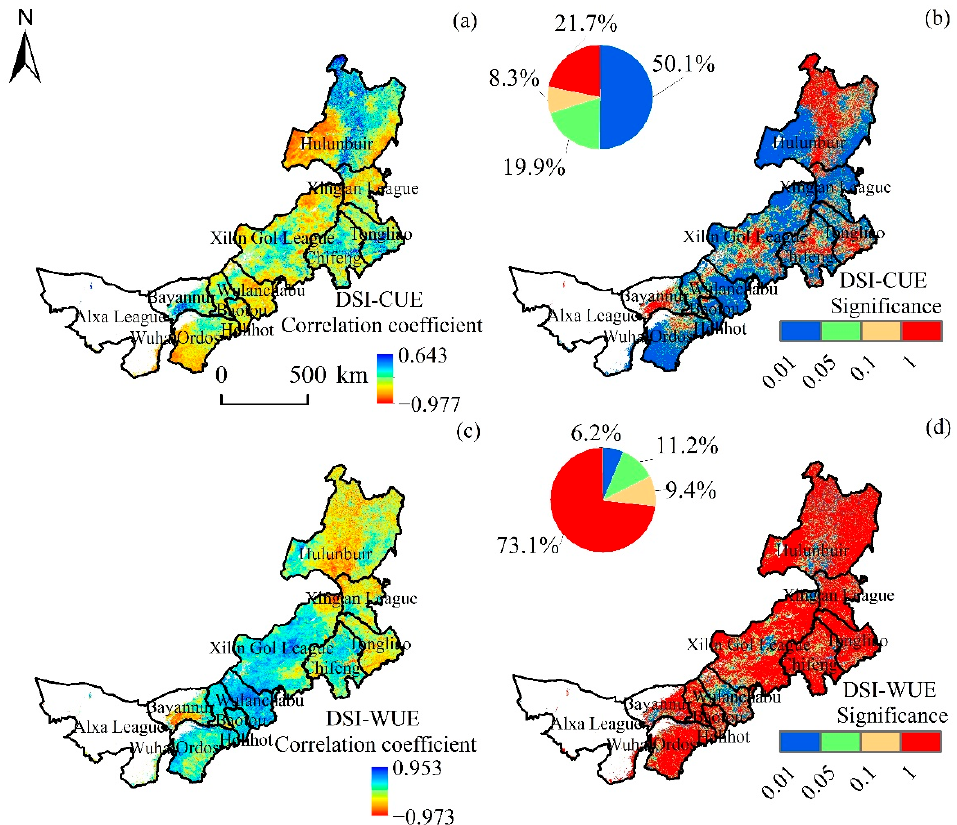
Figure 7. Illustration of the spatial distribution of the correlation coefficients of CUE, WUE, and DSI in Inner Mongolia between the years 2001 and 2020. ( a , b ) Correlations between CUE and DSI and their significance; ( c , d ) correlations between WUE and DSI and their significance.